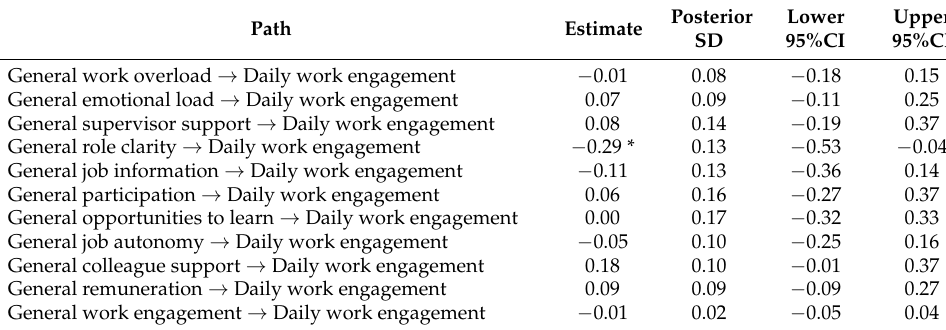
Table 5. Estimates with 95% credible intervals.